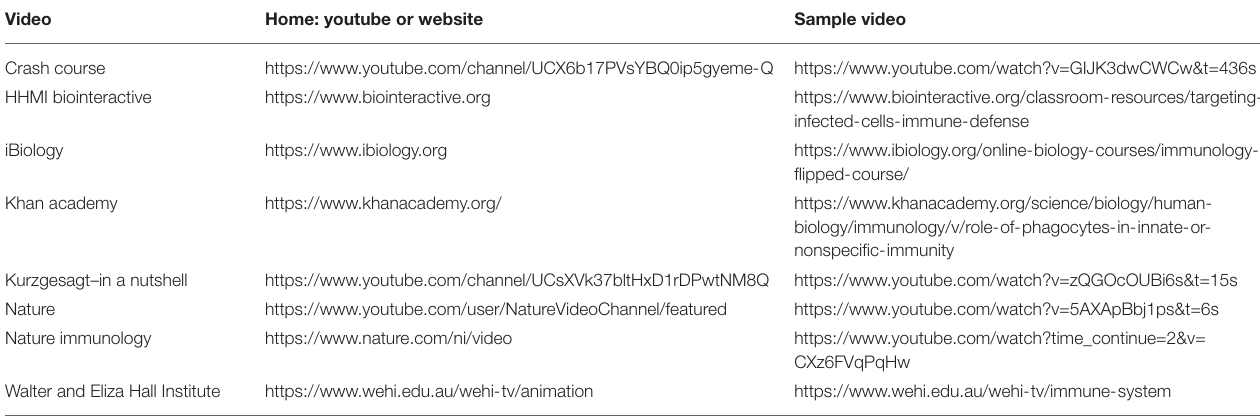
TABLE 2 | A list of immunology video supplements.